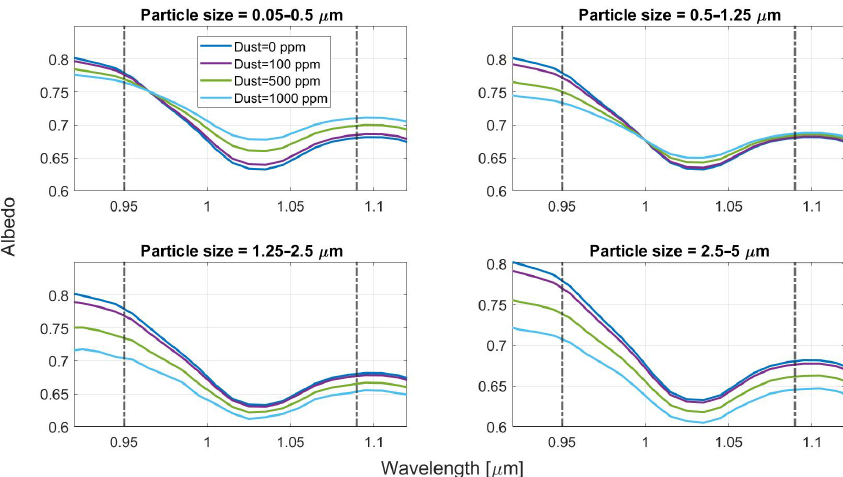
Figure 2. Spectral albedo of snow derived from SNICAR as a function of Saharan dust content at near-infrared wavelengths, given four particle size distributions and r eff = 250µm. The dashed lines indicate the bounds for band area calculations. Dust concentrations at 1 and 10ppm were identical to clean snow with the given configurations and were thus omitted.